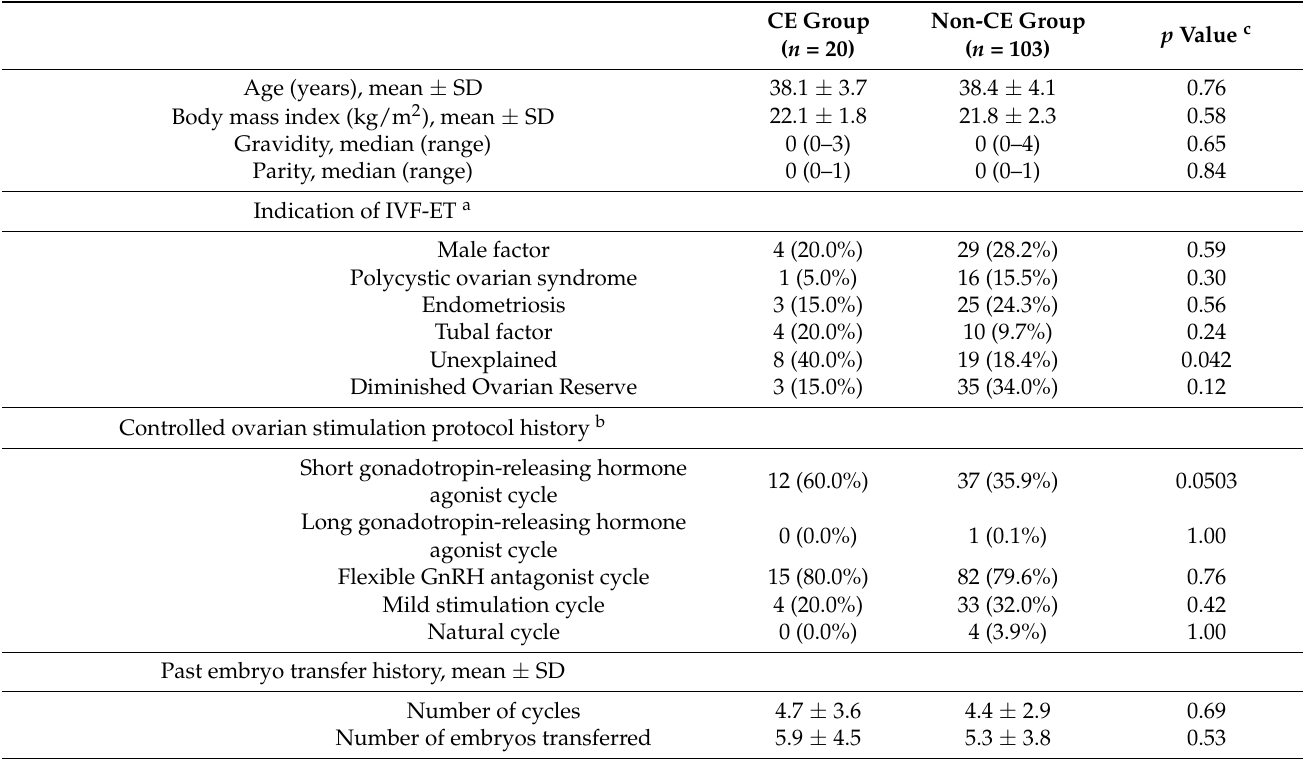
Table 2. Demographics of infertile patients in CE and non-CE